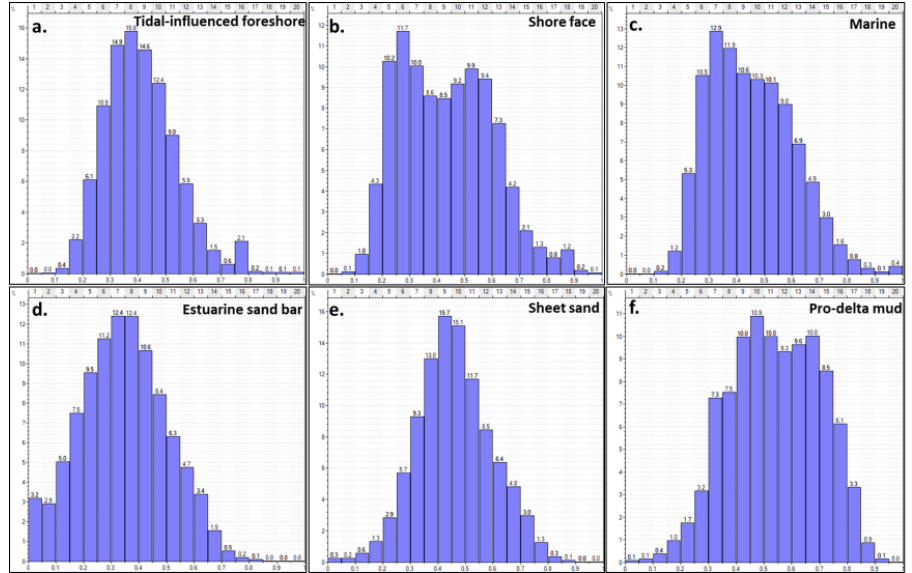
Figure 12. PDFs of the normalized P-impedance trend in different facies in Unit 4 ( a – c ) and Unit 5 ( d – f ). Three facies are identified in Unit 4 and Unit 5, respectively. Unit 4 presents a coastal shore feature, which includes tidal-influenced foreshore, shore face, and marine (from proximal to distal). Unit 5 has a deltaic feature, which includes estuarine sand bar, sheet sand, and pro-delta mud (from proximal to distal). The PDFs of P-impedance trend are different in each facies.